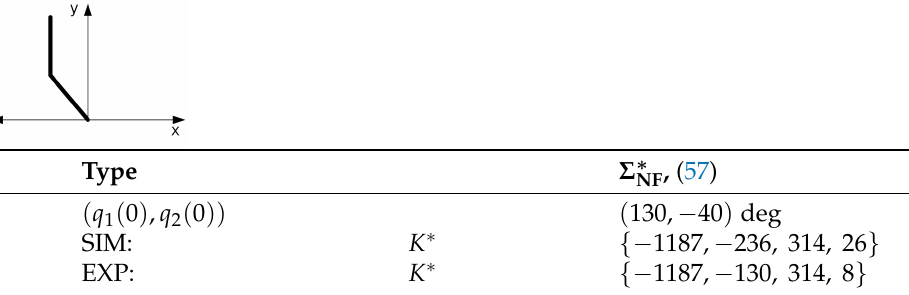
Table 11. Case C2: Initial posture of the Pendubot and parameters of the nonlinear